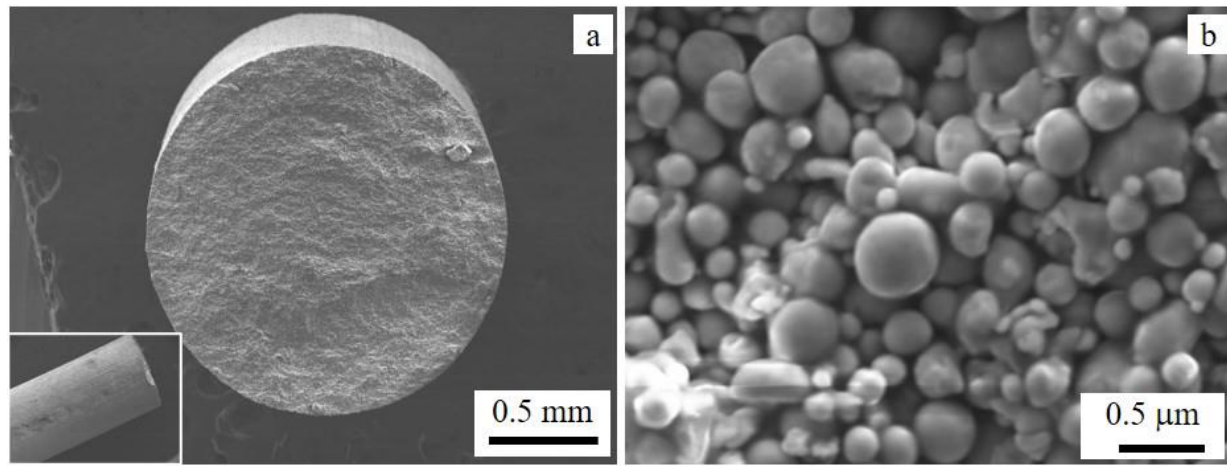
Figure 1. SEM images of a 17-4 ss filament (feedstock material): ( a ) cross-sectional view of a filament 100